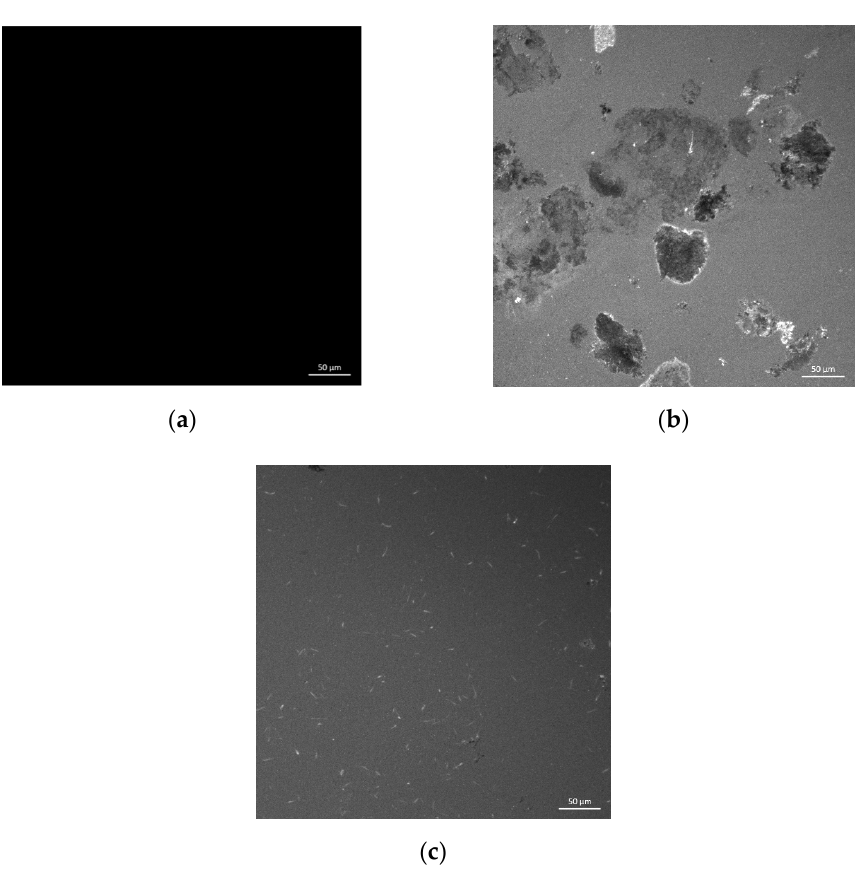
Figure 4. The fluorescence spectrum of ( a ) 70# asphalt; ( b ) RRMA; ( c ) Blend.